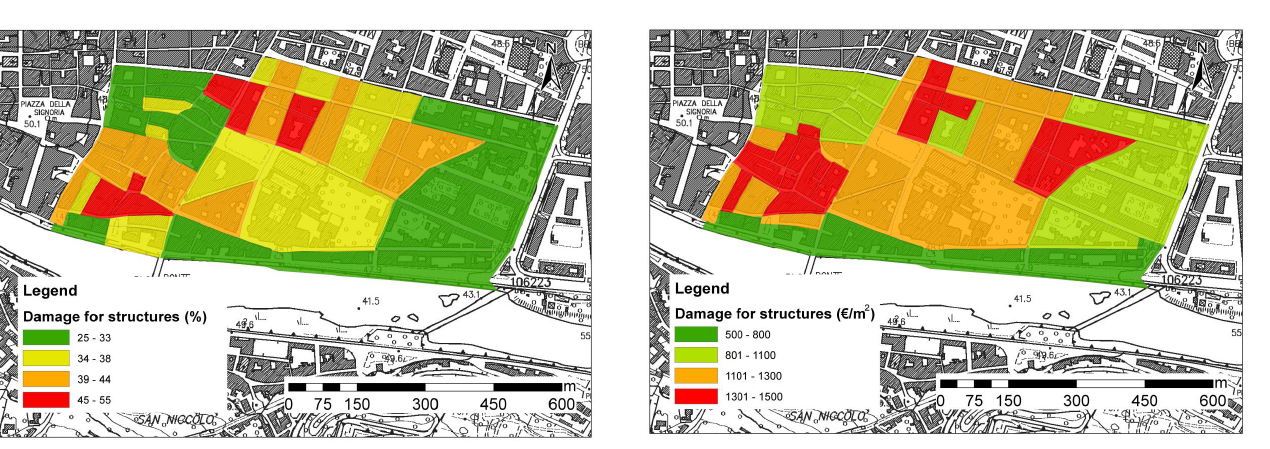
Fig. 10. Per cent structural damage for buildings in the St. Croce Figure 10. Per cent structural damage for buildings in the S. Croce district for the 200 year 2 district for the 200yr flood. flood. 3